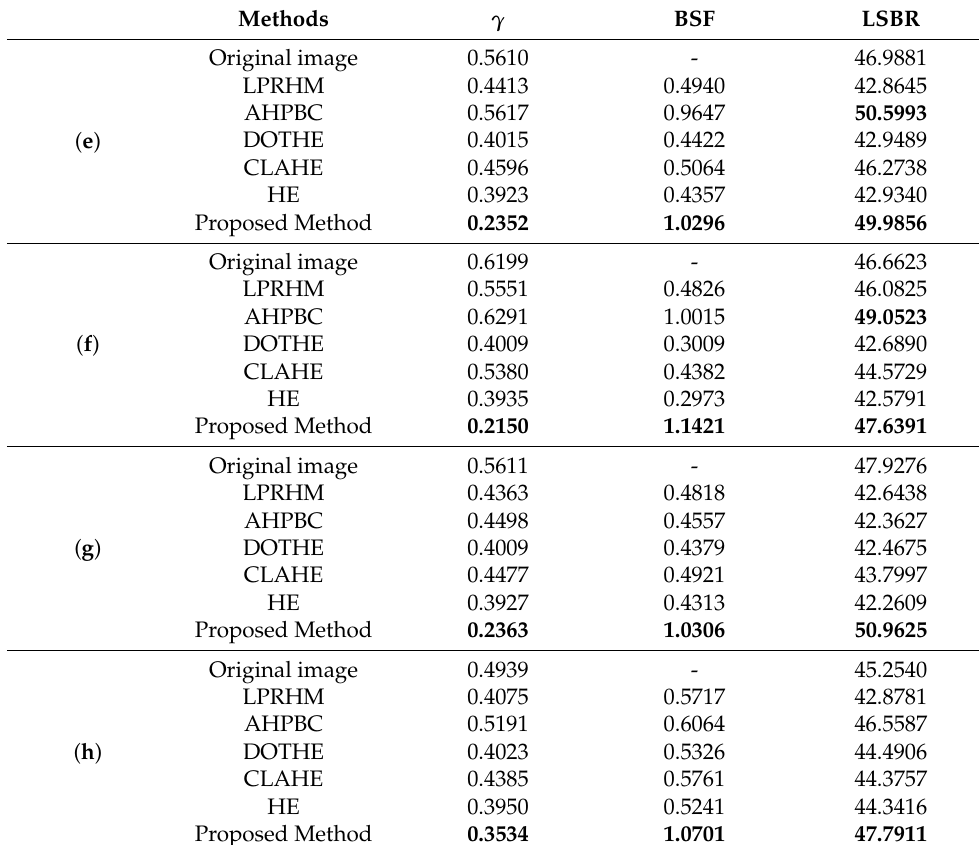
Table 3. The rough sea image quantitative metrics. (e–h) correspond to the rough sea infrared images in Figure 16e–h, respectively. Different methods process the four